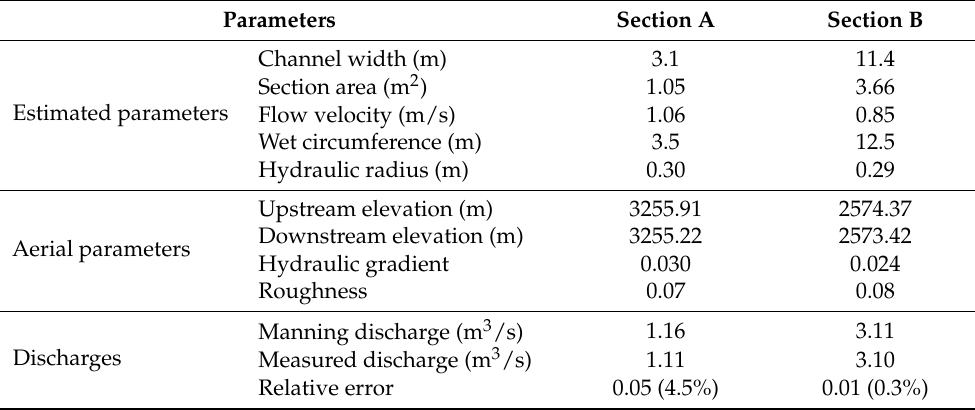
Table 2. Estimated parameters, aerial parameters, and discharges of two